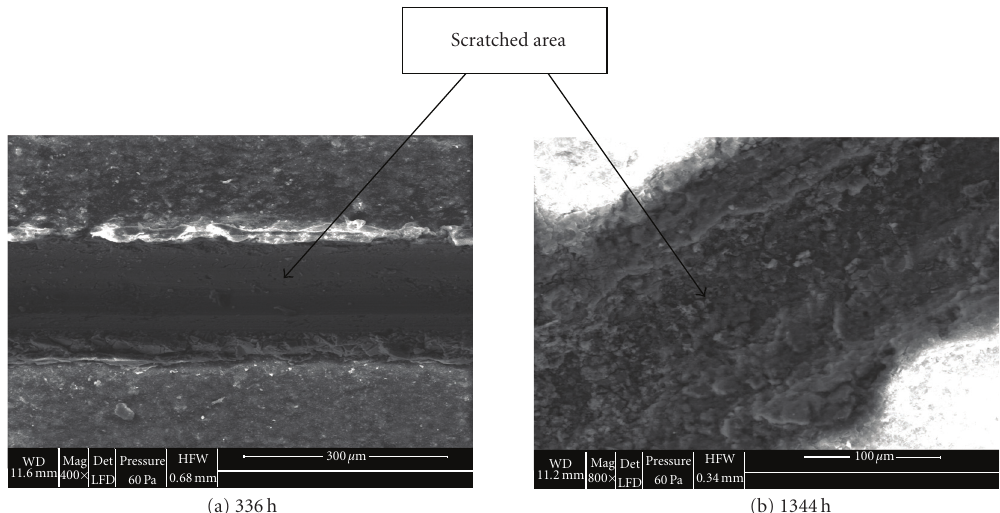
Figure 7: Morphology of scratched samples after 336-hour and 1344-hour exposure test.